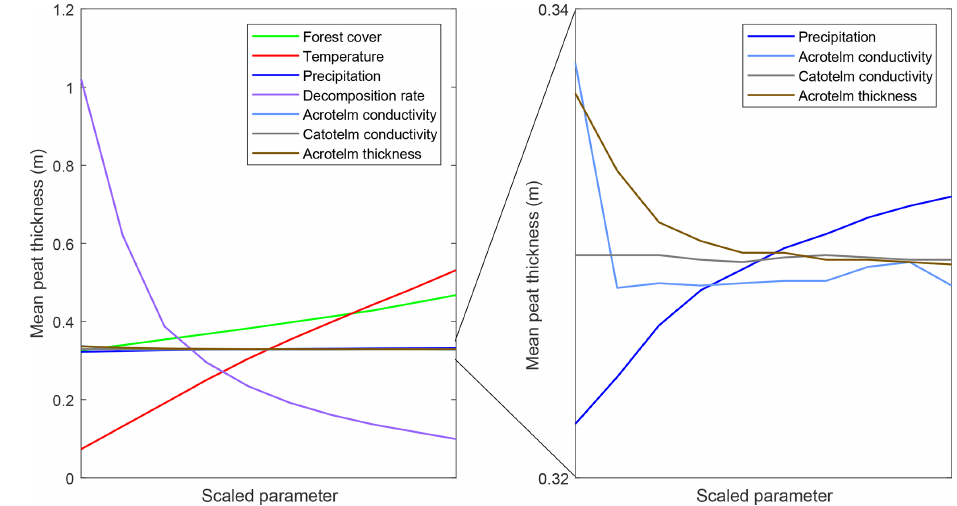
Figure 11. Mean simulated peat thickness for all variables used in the parameter sensitivity